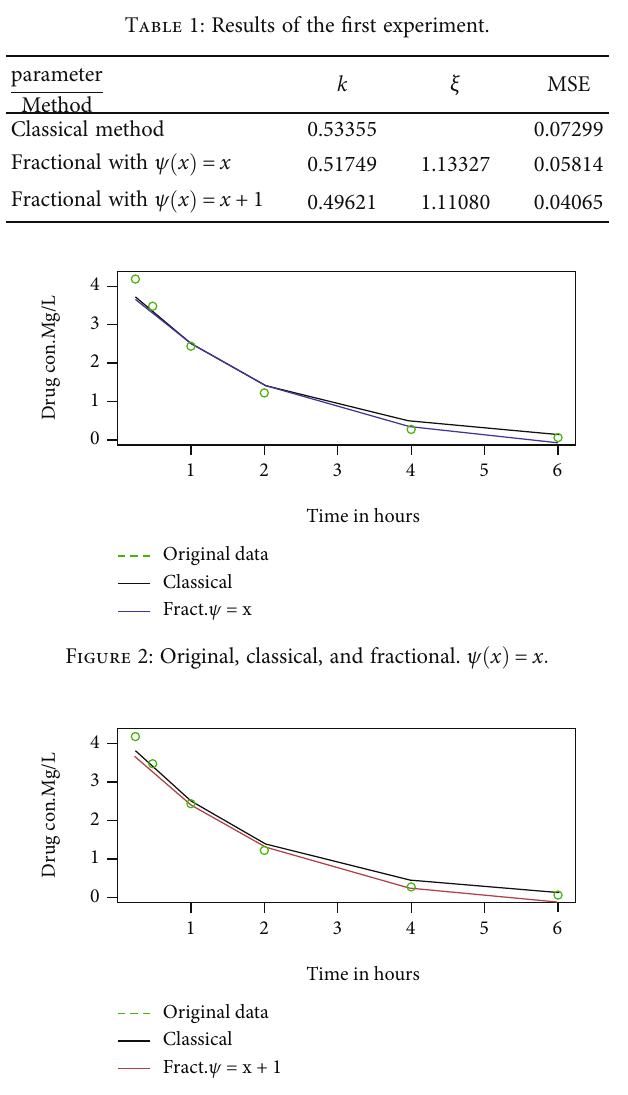
Figure 3: Original, classical, and fractional. ψ ð x Þ = x + 1 . Table 2: Results of the second experiment.